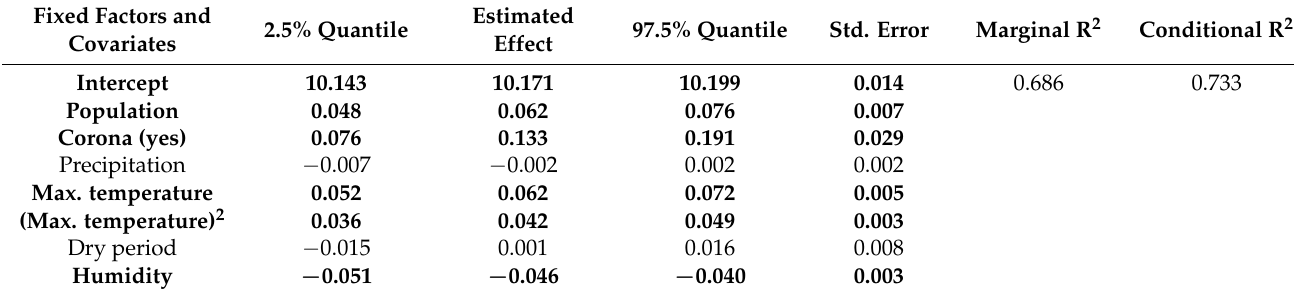
Table 2. Estimates and their 95% credible intervals from the linear mixed model analysis for water volume rates. For the fixed-factor Corona (yes/no) the effect is given for presence of Corona measures compared to no measures. Significant estimates are shown in bold. N =